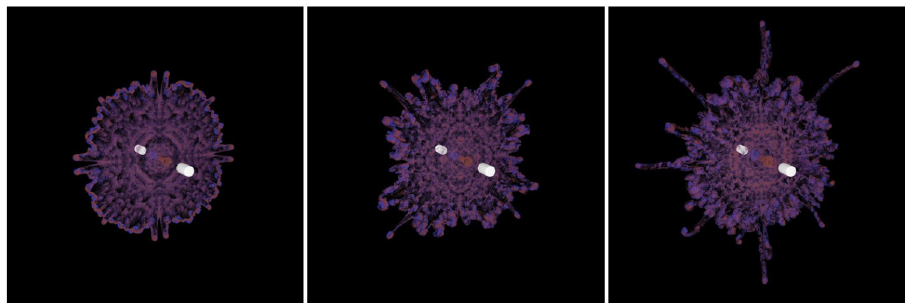
Fig 5. Colliding vortex rings with different δ at frames 400. Two regions of red and blue ink are initialized to show the motion of vortex rings. Left: δ = 0.4; middle: δ = 0.8; right: δ = 1.